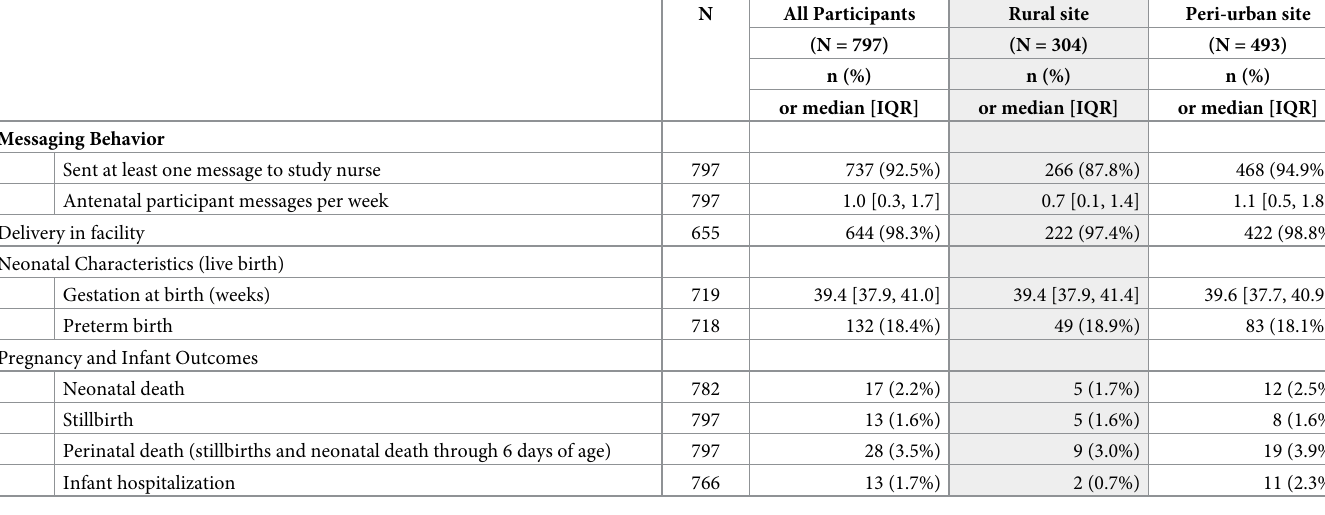
Table 2. Participant messaging behavior and pregnancy outcomes by site.